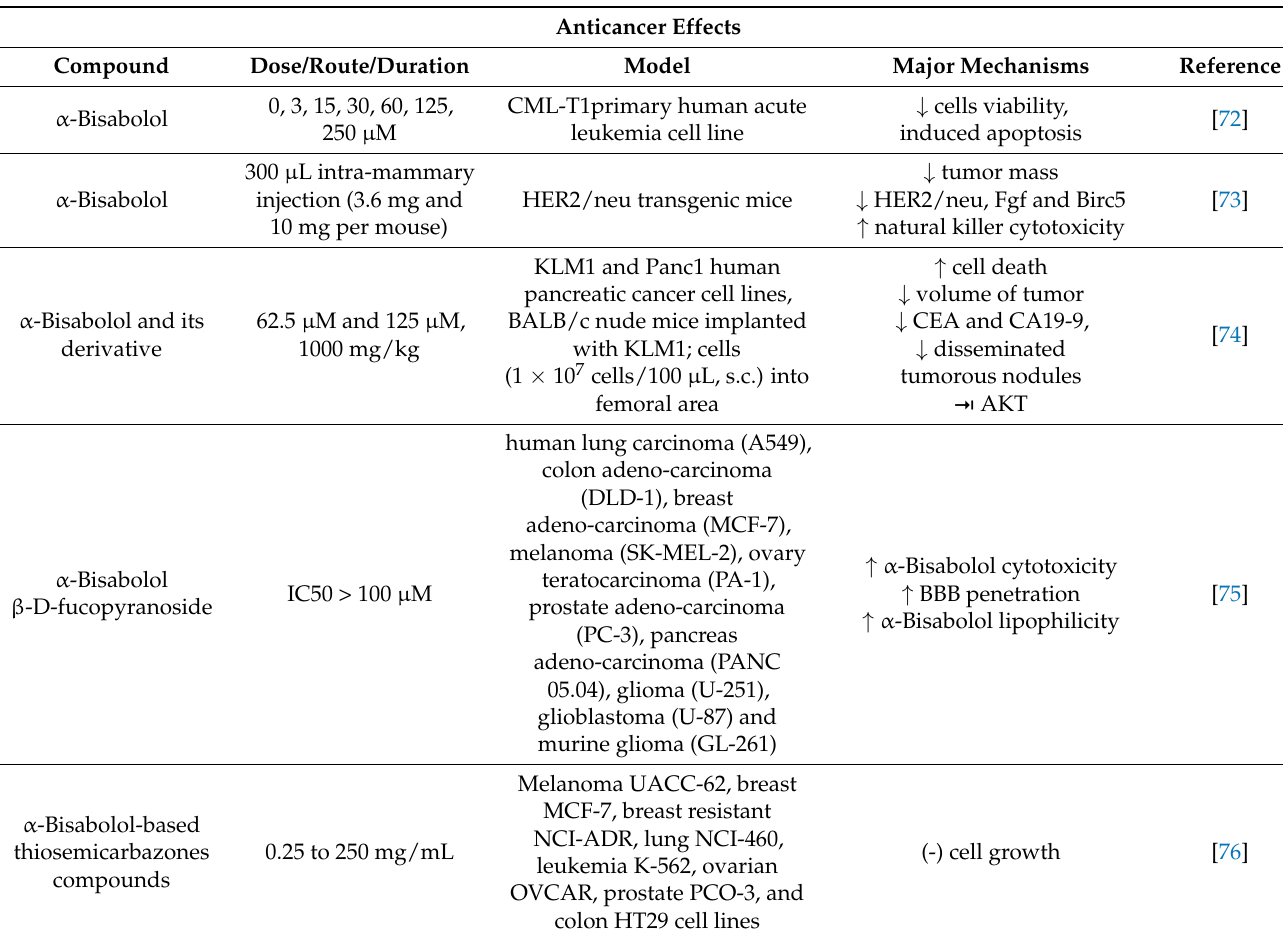
Figure 2. Neuroprotective mechanisms of α-Bisabolol against neurodegeneration. ; increase, ;de- crease. 4. α-Bisabolol and Anticancer Effects Cancer is characterized by cellular overgrowth with abnormal proliferation which can metastasize to surrounding tissues. Cancerous cells have dysregulated cell division cycle lacking the tight control required for regulated cell replication resulting in an altered